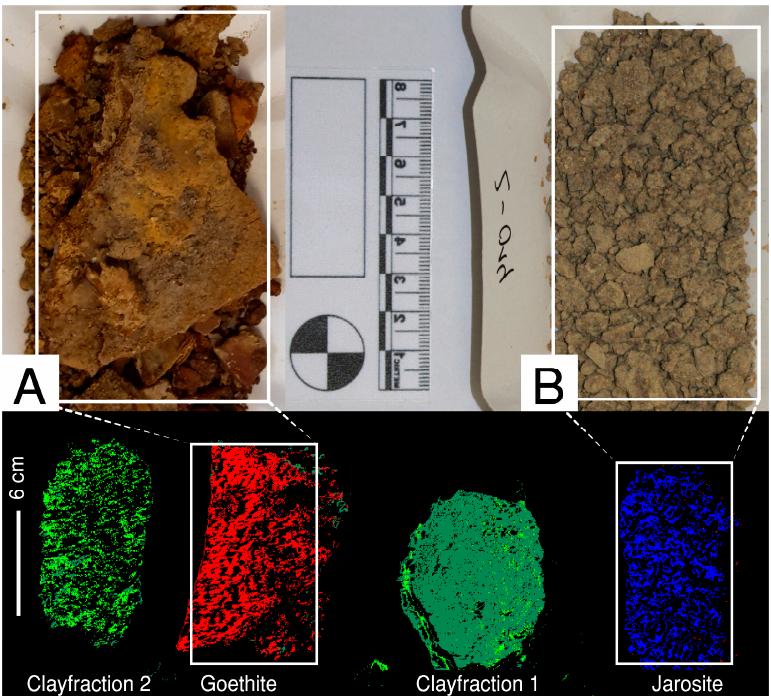
Figure 3. ( A , B ) display sample trays with material from Litov, selected as training classes. For the supervised classifications, the extracted endmember are displayed below. Their averaged spectra are used for the validation. Their color codes are later assigned for the supervised classification maps.